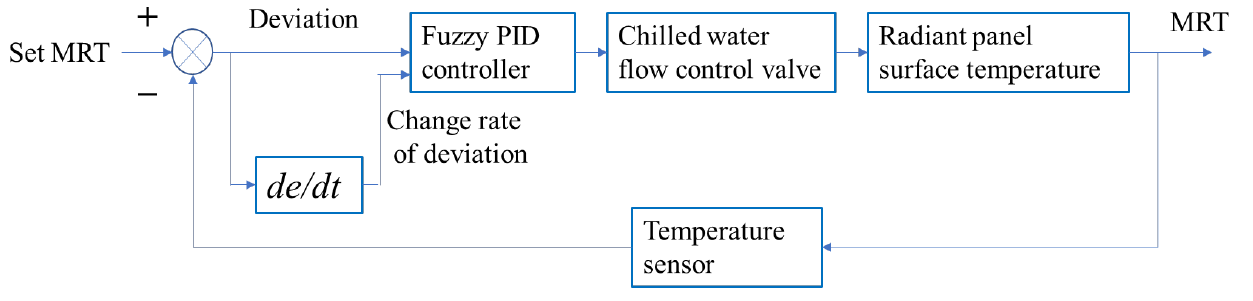
Figure 12. The fuzzy PID control system.